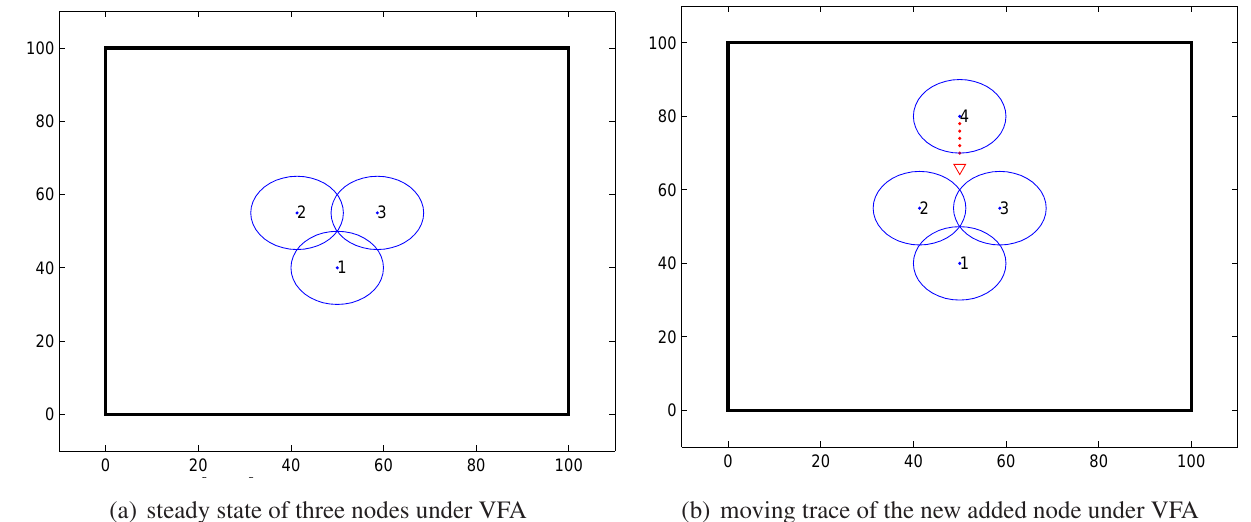
where n denotes the number of sensors in the WSN.